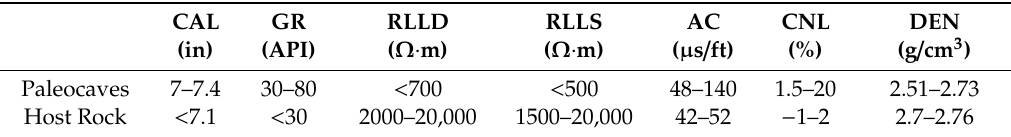
Table 1. Well-logging responses of caves and host rock.